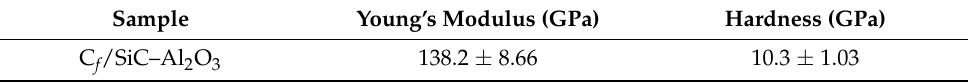
Table 6. The nano-indentation of Young’s modulus and hardness of the C f /SiC-Al 2 O 3 composites. Figure 10. Load displacement curves of the SiC matrix for the C f /SiC-Al 2 O 3 composites under a maximum indenting load of 400 mN.